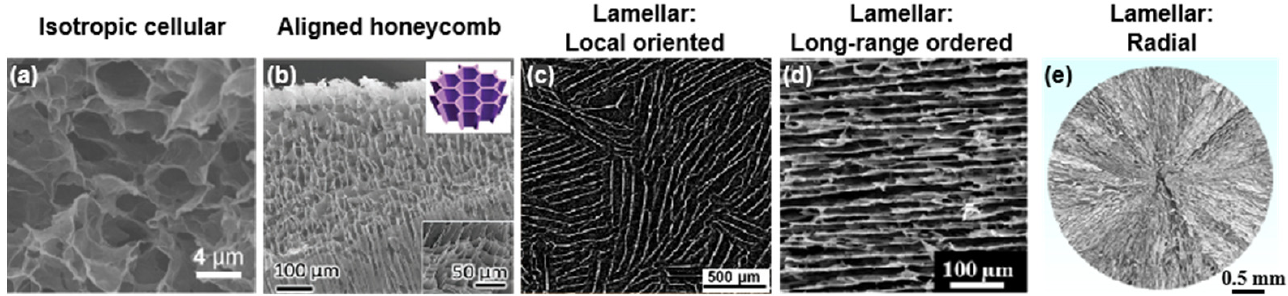
Figure 3. Five typical microstructures in MXene-based porous monoliths: ( a ) isotropic cellular, ( b ) aligned honeycomb, ( c ) local oriented lamellar, ( d ) long-range ordered lamellar, and ( e ) radial la- mellar structures. ( a ) is reproduced with permission from ref. [34]. Copyright 2018, American Chem- ical Society. ( b ) is reproduced with permission from ref. [59]. Copyright 2020, Wiley-VCH. ( c ) is reproduced with permission from ref. [55]. Copyright 2022, American Chemical Society. ( d ) is re- produced with permission from ref. [60]. Copyright 2019, American Chemical Society. ( e ) is repro- duced with permission from ref. [53]. Copyright 2022, American Chemical Society.